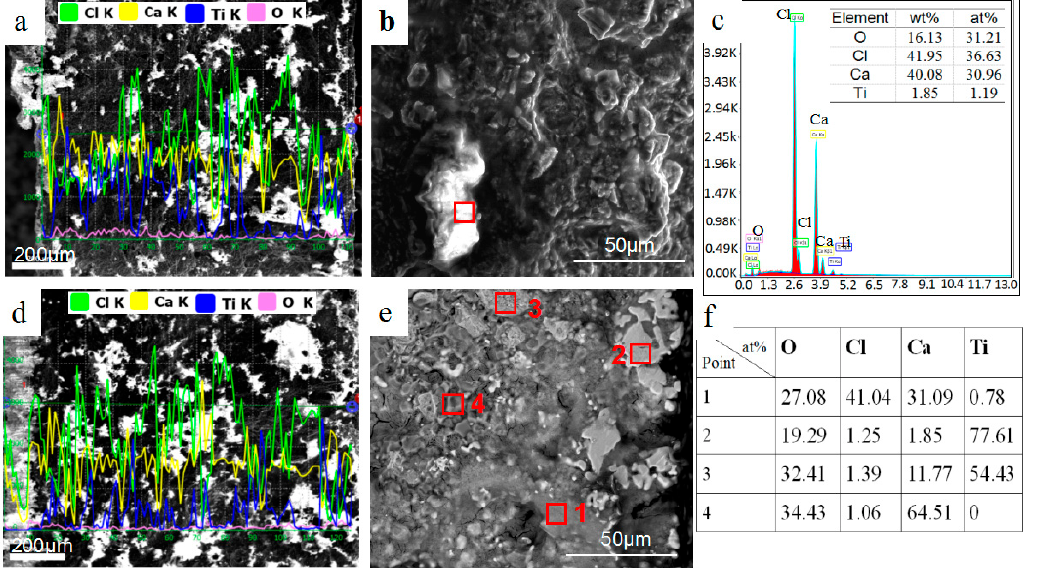
Figure 5. The cross section and EDS analysis of reduction products with different temperature: ( a ) line ‐ scan image of reduction product at 1173 K; ( b ) microstructure of reduction product at 1173 K; ( c ) EDS result of ( b ); ( d ) line ‐ scan image of reduction product at 1273 K; ( e ) microstructure of reduction product at 1273 K; ( f ) EDS results of ( e ).